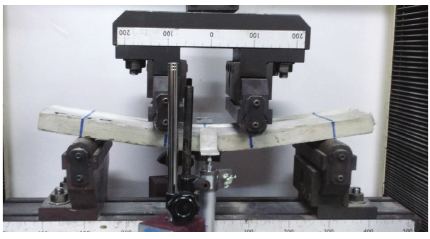
Figure 9: Flexural deflection of ECC-FASL